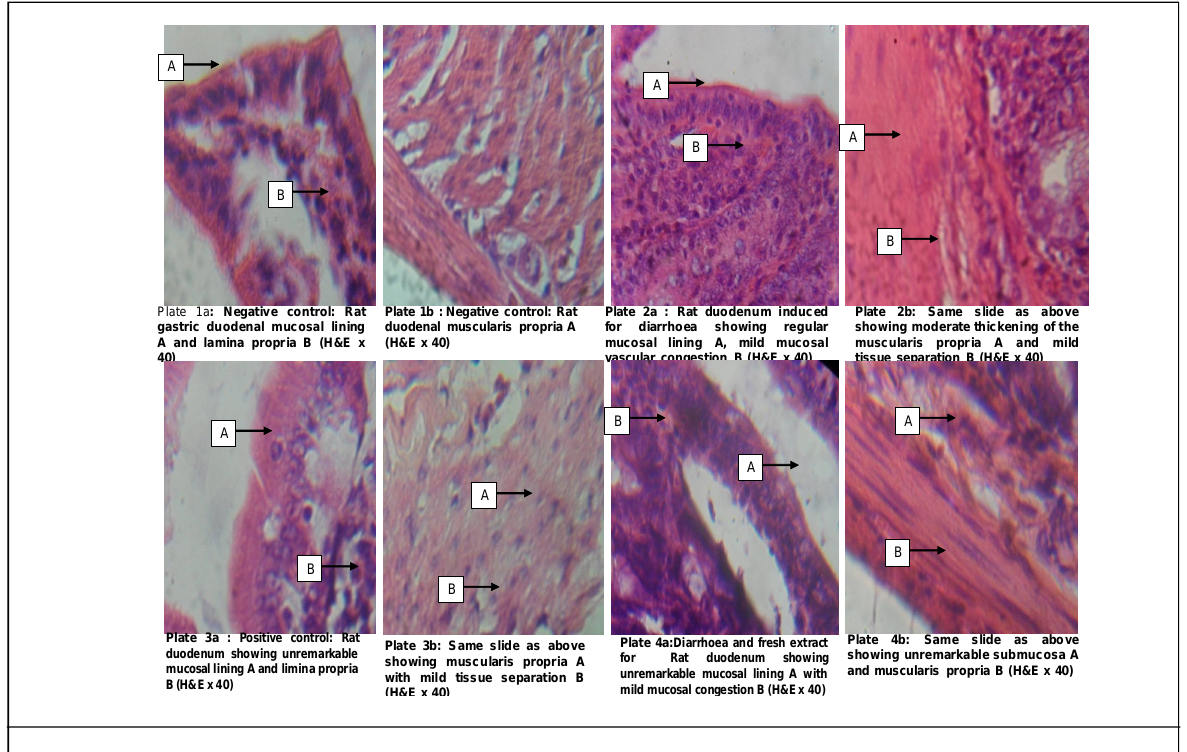
Plate A: Histology of the small intestine of lactose induced diarrheic rats treated with M. lucida